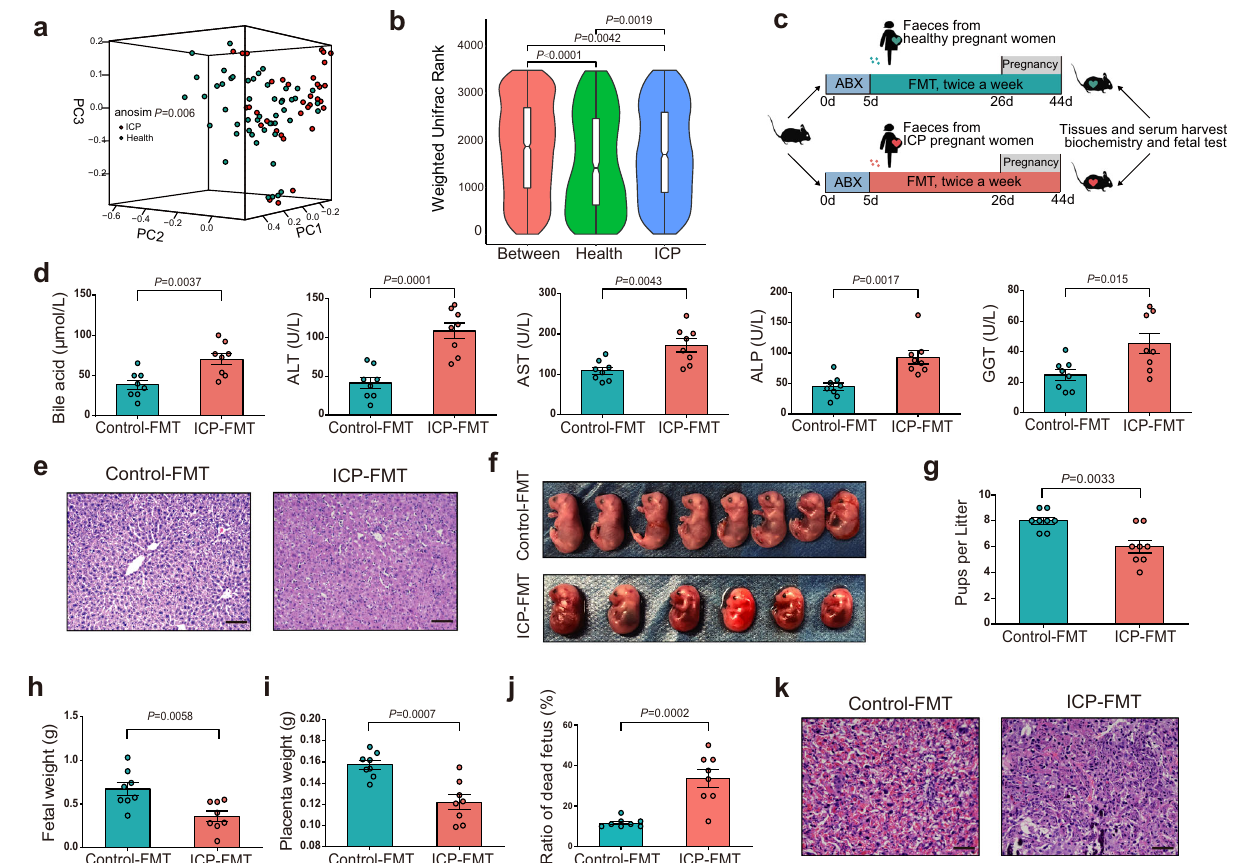
Fig. 1 | Gut microbiota from ICP patients is altered signi fi cantly and suf fi cient to promote ICP in mice. a Weighted Unifrac PCoA (principal coordinate analysis) plot of individuals with ICP patients and healthy controls. The ANOSIM test was used to calculate the signi fi cance of dissimilarity (ANOSIM, P =0.001). b A trun- cated violin plot shows the comparison of Weighted Unifrac range of samples between ICP patients and healthy controls. The notch in the middle of the box represents the median. The top and bottom of box represent the 75th and 25th quartiles, respectively. The upper and lower whiskers extended 1.5× the inter- quartilerangefromtheupperedgeandloweredgeoftheboxrepresentmaximum and minimum, respectively. With a truncated violin plot, the curve of the violin extends only to the minimum and maximum values in the data set. Outlier values werenotshowninthisplot. n =50individualswithICP, n =41individualsinhealthy controls. The ANOSIM test was used to calculate the signi fi cance of dissimilarity. The exact P values were shown. c Experimental schematic: following antibiotics